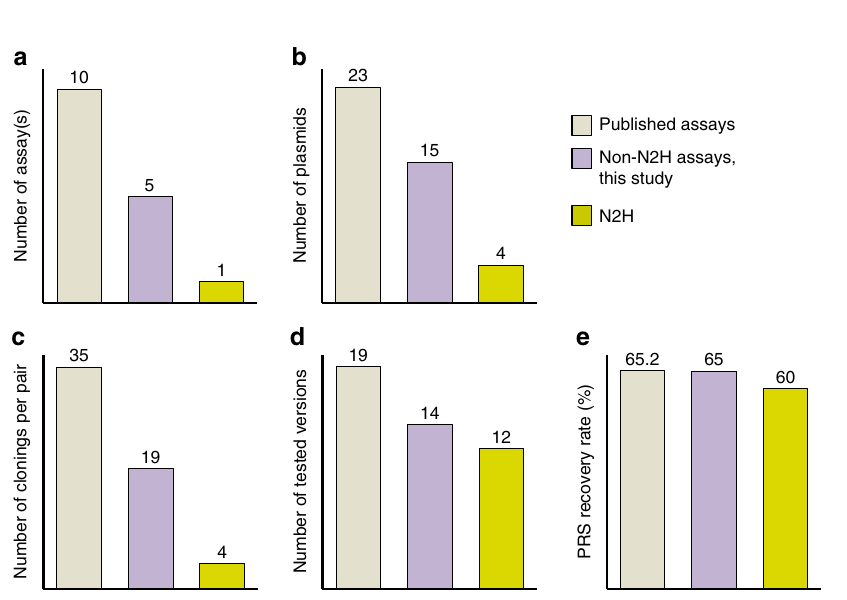
Fig. 4 Invested resources for various combinations of binary PPI assays and PRS detection rates. Numbers of ( a ) assays, ( b ) plasmids, ( c ) clonings per pair, and ( d ) tested versions required to achieve the PRS recovery rates presented in ( e ). PRS recovery rates presented in Fig. 4e correspond to those found in Fig. 2b (published), Supplementary Fig. 5b (non-N2H) and Fig. 3f (N2H). Except for Y2H-N1C2, Y2H-C1C2, and Y2H-C1N2 for which unambiguous titrations could not be obtained from the original study 28 , all published assay versions benchmarked against hsPRS-v1 and hsRRS-v1 were used (Fig.